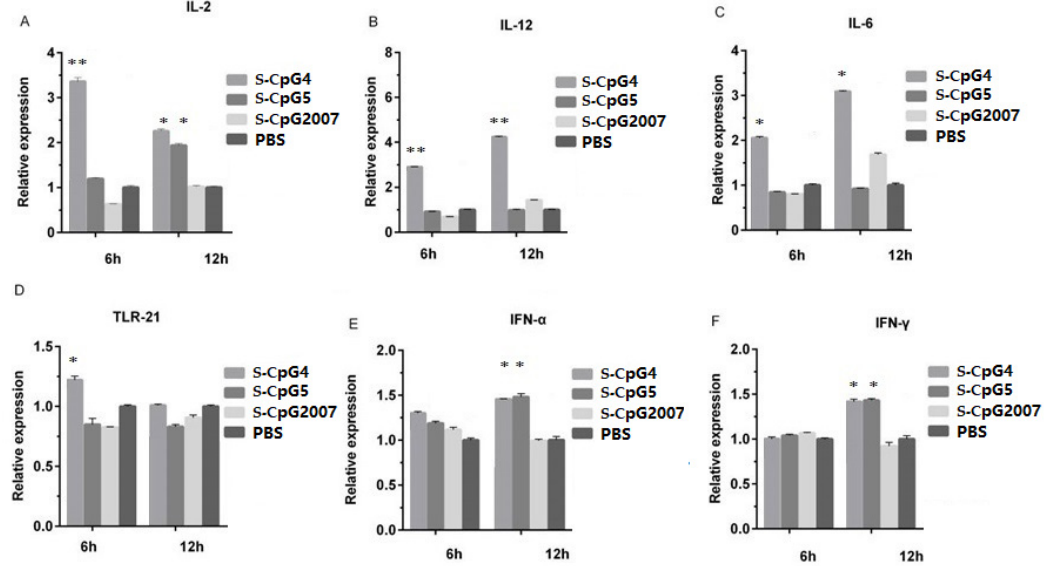
Figure 4. Effect of S-CpG on the mRNA expression of CEF-related immune genes. CEFs were treated with 1 µ g/mL S-CpG4, 5 and S-CpG2007 for 6 and 12 h. The expressions of IL-2 ( A ), IL-12 ( B ), IL-6 ( C ), TLR-21 ( D ), IFN- α ( E ) and IFN- γ ( F ) were detected with qPCR. All data were presented as mean ± SD. * p < 0.05, ** p < 0.01.